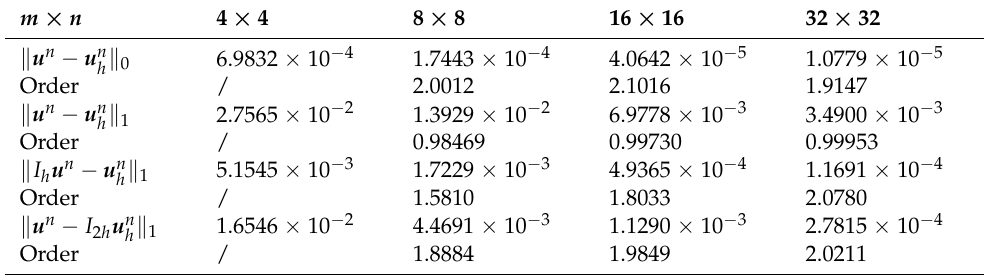
Table 1. The numerical errors and convergence orders at t = 0.1 of u . m ×